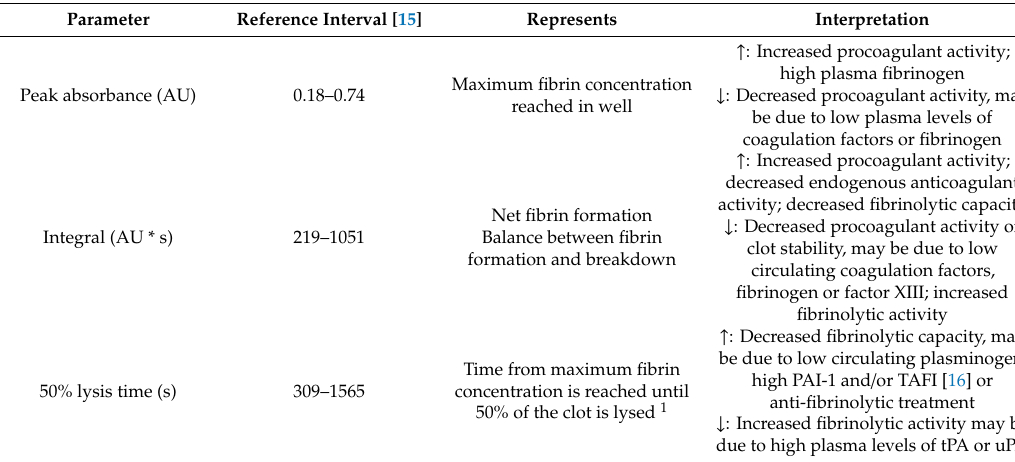
Table 1. Interpretation of clot-lysis results.